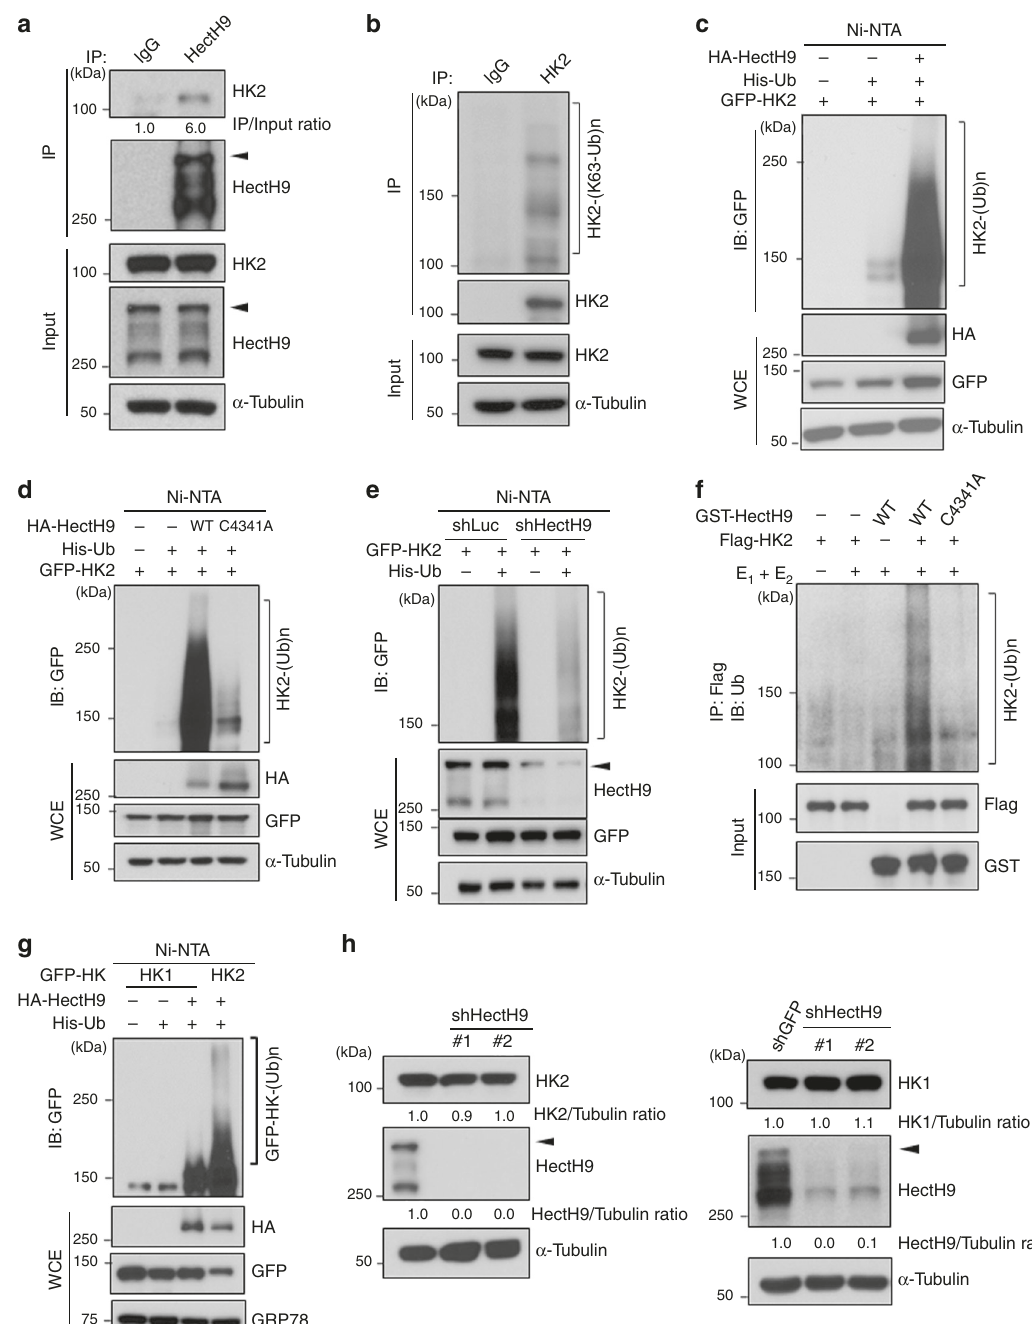
Fig. 2 HectH9 promotes K63-linked ubiquitination of HK2. a PC-3 cell lysates were harvested for immunoprecipitation (IP) with IgG or anti-HectH9 antibody, followed by immunoblot (IB) analysis with indicated antibodies. The ratio of immunoprecipitated HK2 to total HK2 levels in the input was quanti fi ed using ImageJ software. Arrowhead indicates the full-length of HectH9 and signals underneath represent HectH9 fragments. b PC-3 cell lysates were harvested for IP with IgG or anti-HK2 antibody, followed by IB analysis with indicated antibodies. c and d In vivo ubiquitination assay of HK2 by HectH9. HEK293T cells transfected with indicated plasmids were harvested for ubiquitination assay. Cells were lysed by denatured buffer. The ubiquitinated proteins were precipitated with nickel (Ni)-NTA beads and subjected to IB analysis. NTA indicates nickel bead precipitate; WCE indicates whole-cell extracts. e HEK293 cells with Luciferase or HectH9 knockdown were transfected with indicated constructs and harvested for in vivo ubiquitination assay. f Puri fi ed catalytically active form (WT) or defective mutant (C4341A) of GST-HectH9 proteins were incubated with adenosine triphosphate, E1 (Ube1) and E2 (Ubc13), with or without puri fi ed Flag-HK2 for in vitro HK2 ubiquitination assay. g HEK293T cells transfected with indicated constructs were harvested for in vivo ubiquitination assay. h IB analysis of HK2 and HK1 expression in PC-3 cells with GFP or HectH9 knockdown. Two HectH9 lentiviral shRNAs were used in this assay. The relative intensity of protein expression as indicated was quanti fi ed with ImageJ software and normalized to α -Tubulin expression. Immunoblots were performed three